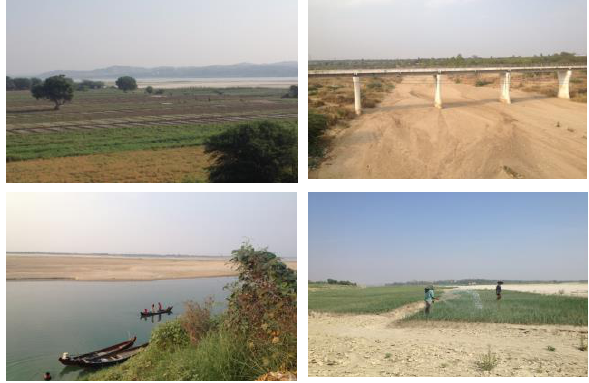
Figure 5. Study area photographs during ground truth and field verification in central dry zone area of